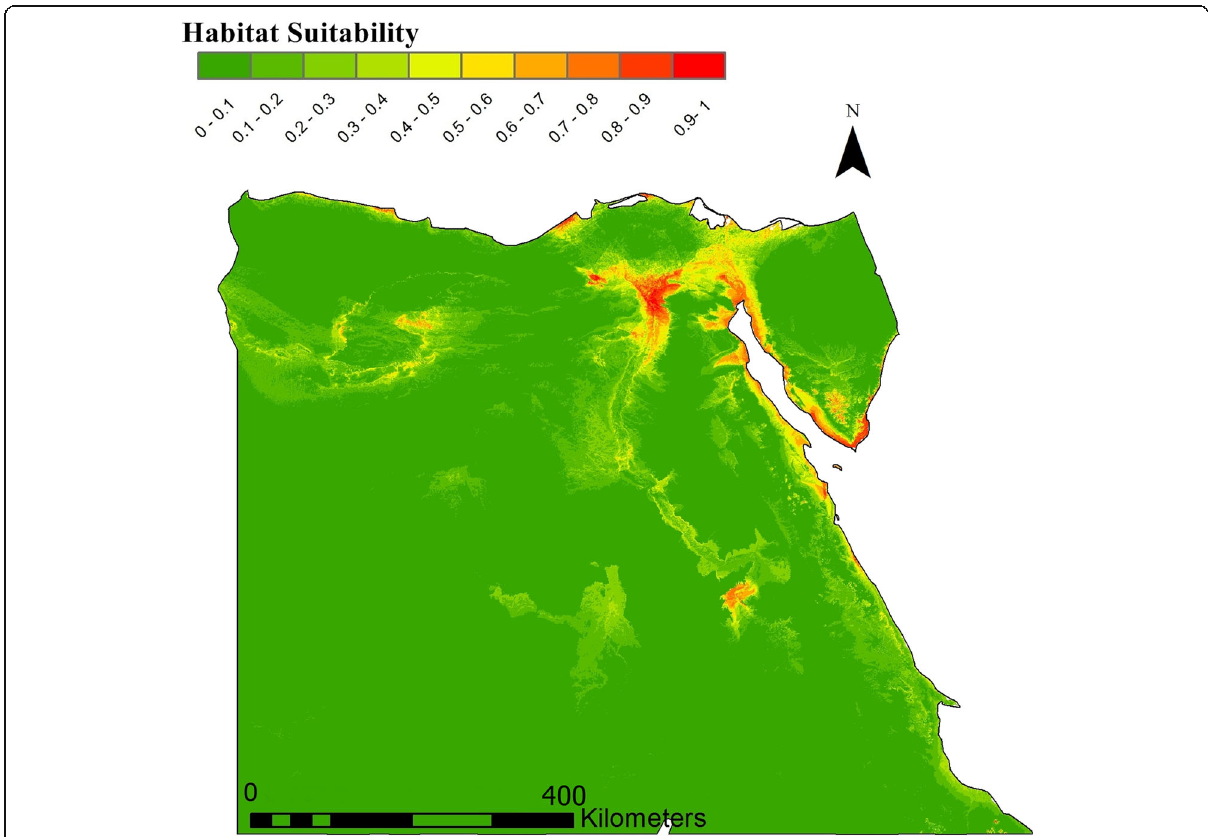
Fig. 3 Habitat suitability of Mantodea species in Egypt according to occurrence